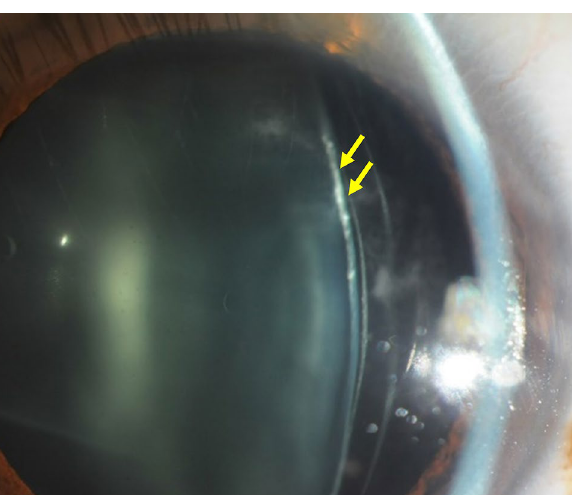
Figure 1. A representative photograph of anterior subcapsular cataract formation in the peripheral area after implantable collamer lens (ICL)